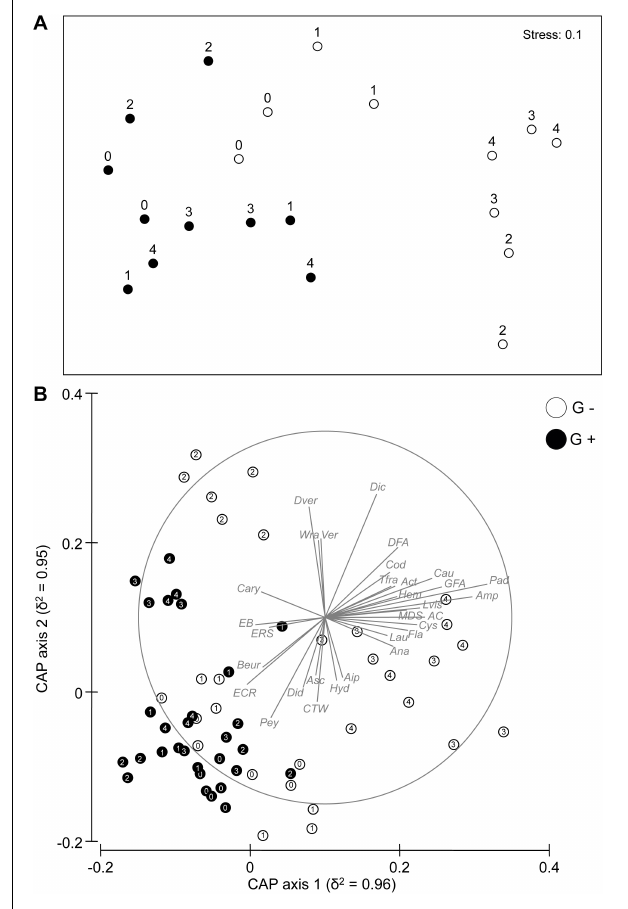
FIGURE 2 | (A) Non-metric multidimensional scaling (nMDS) ordination of Ti × Si(Tr) centroids on the basis of Bray–Curtis dissimilarities for the rocky bottom assemblages. (B) Canonical analysis of principal coordinates (CAP) for the factor Ti × Tr at the different sampling times (T0:T4). Individual taxa highly correlated with canonical axes are shown. Abbreviations for taxa used in CAP plots are given in Supplementary Table S2 . Numbers (from 0 to 4) indicate the sampling times. G+, control sites; G–, culling